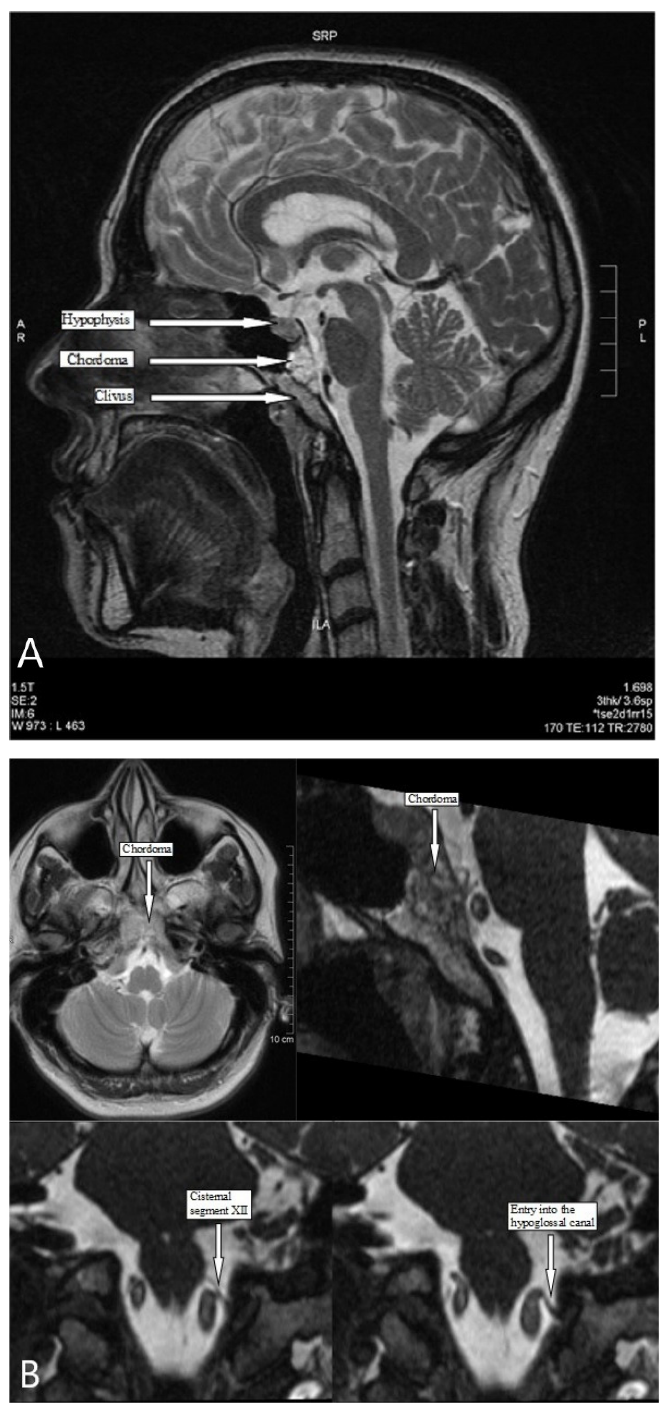
Figure 2. ( A ) MR ‐ imaging, sagittal plane: Chordoma in the clivus area. ( B ) Cisternal segment and entry of the 12th cranial nerve into the hypoglossal canal.